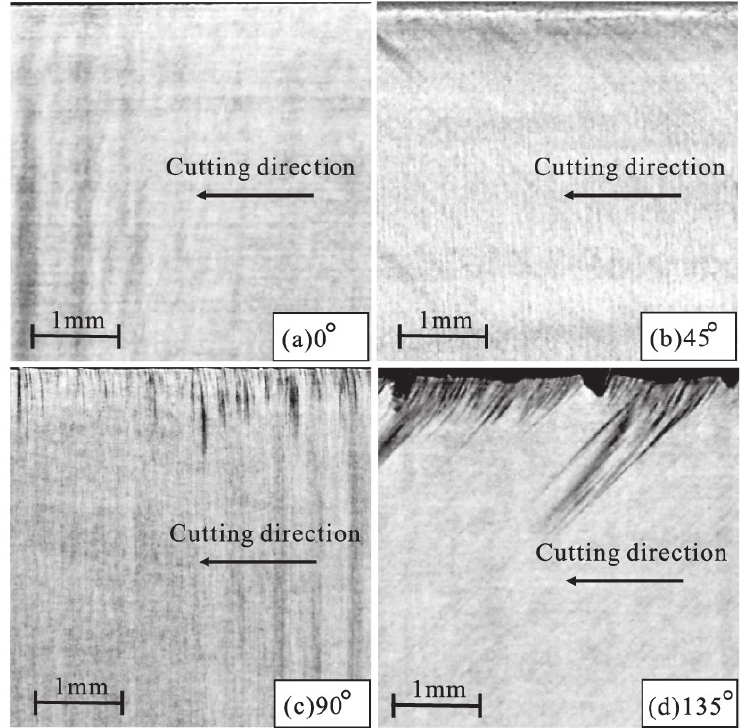
Figure 9. Schematic of simulation setups of CFRP orthogonal cutting [25].